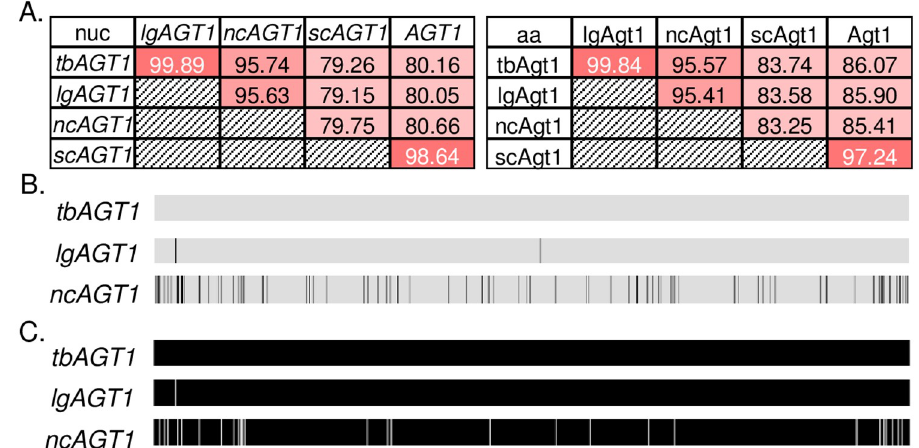
Fig 1. Alignment of AGT1 -like genes. A) Tables highlighting the nucleotide (nuc) and amino acid (aa) percent identities between members of the AGT1 family. Darker colors indicate greater sequence similarity. B) Multiple sequence alignment between nucleotide sequences of tbAGT1 , lgAGT1 , and ncAGT1 . Black lines indicate nucleotide differences. C) Multiple sequence alignments between protein sequences of tbAGT1 , lgAGT1 , and ncAGT1 . White gaps indicate amino acid